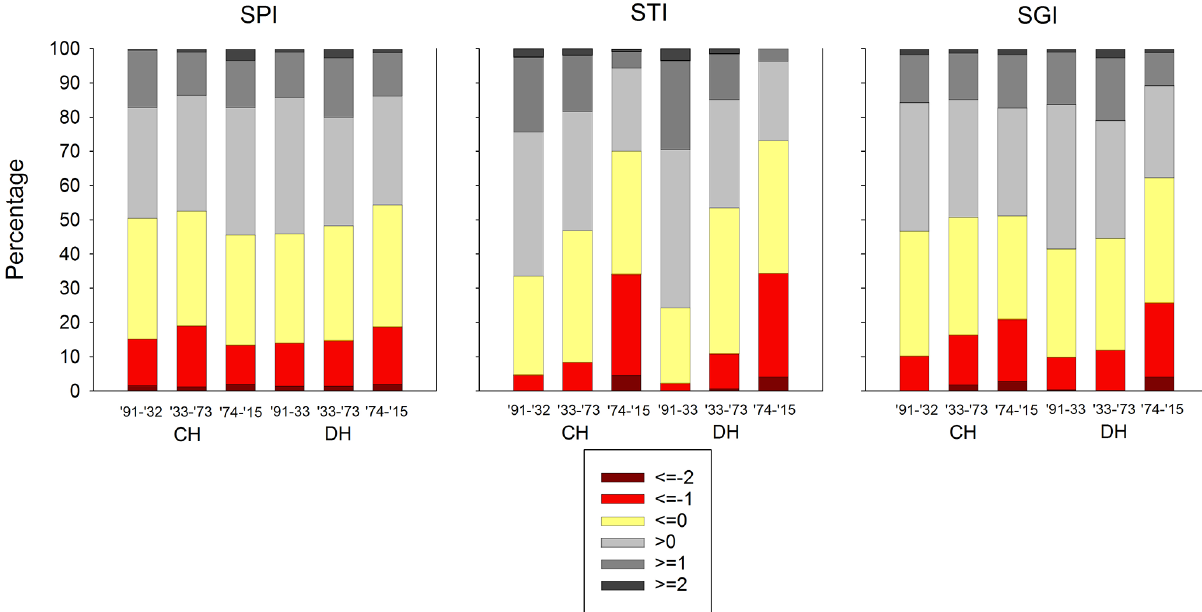
Figure 3. Percentage of monthly SPI, STI and SGI as a function of six ranges of standardised values from ≤ − 2 to ≥ 2 for each third of the records from CH and